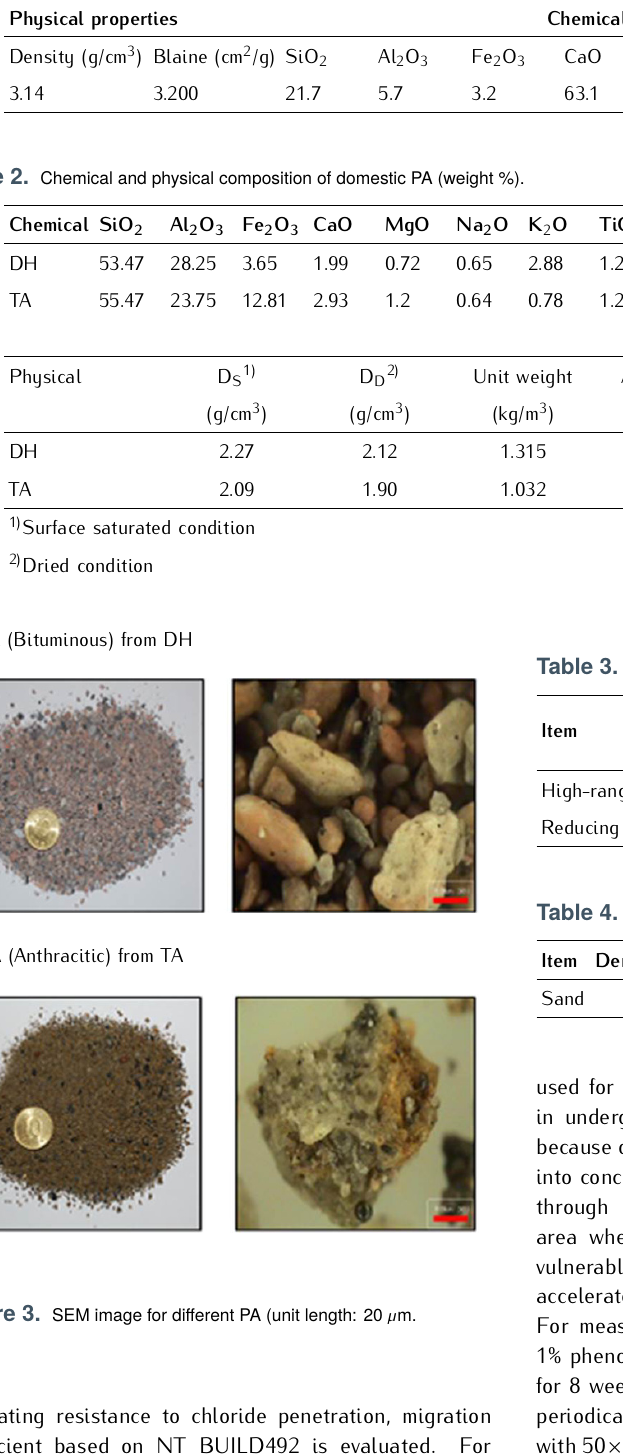
evaluating resistance to chloride penetration, migration coefficient based on NT BUILD492 is evaluated. For this test, disk samples (10 cm of diameter × 5 cm of height) are prepared and 0.1N AgNO 3 indicator is